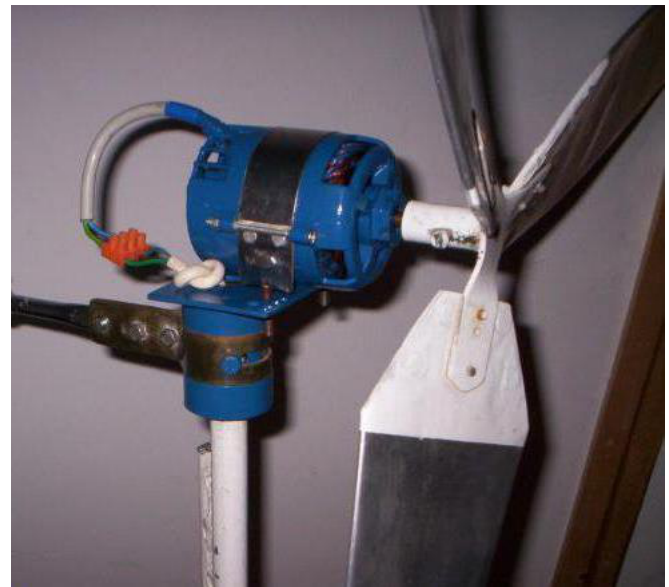
Figure 2. Wind turbine in disassembled form (blades and engine).